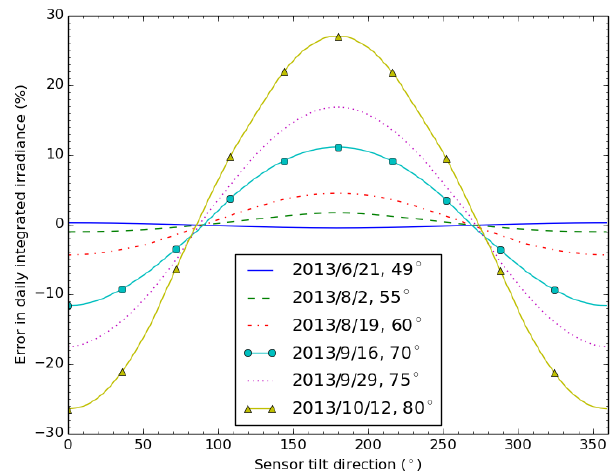
Figure 3. Error in daily integrated irradiance (see Eq. (14)), plotted against sensor tilt azimuth. Dates are chosen to show a local noon solar zenith angle of 49 ◦ (solstice), 55, 60, 70, 75, and 80 ◦ , respec- tively, reading down the